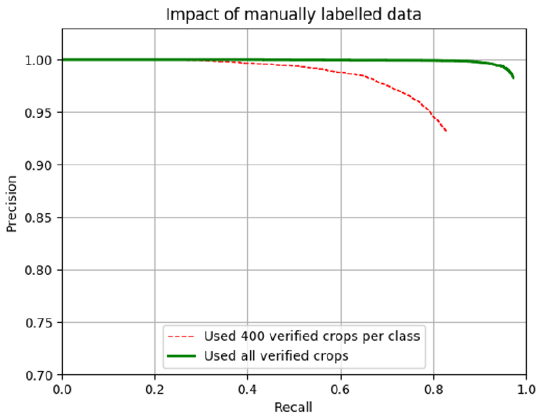
Figure 3. Significant improvements in recognition accuracy when using more verified signs 12